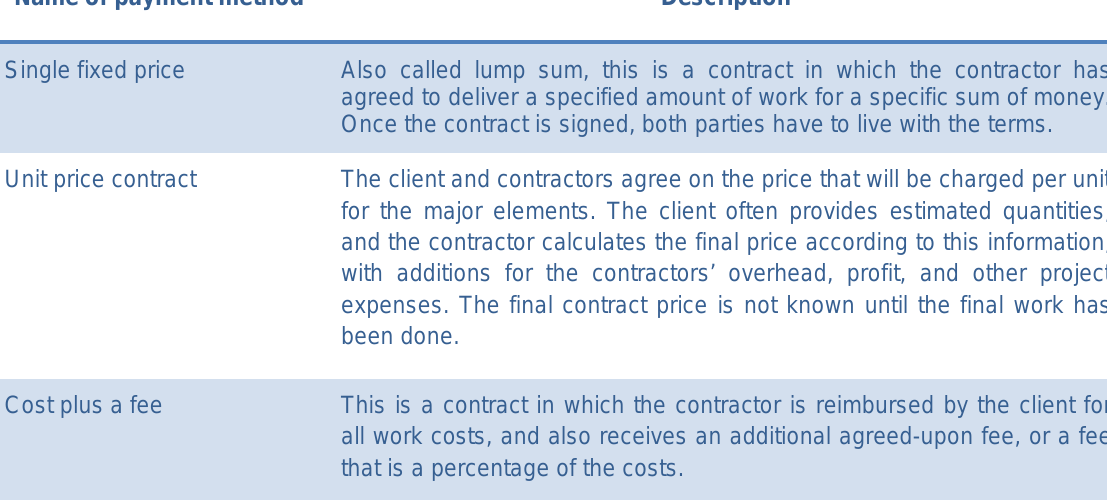
Table 5: Payment method structure in Gould & Joyce (2011, Ch. 4)